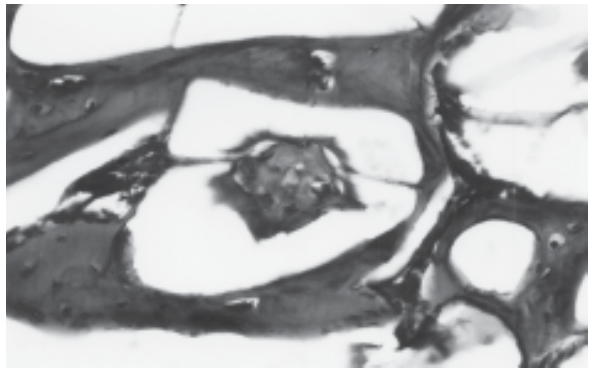
FIGURE 5 - PG 30 days. Spaces filled with particles surrounded by more mature bone tissue; indications of remodeling (A). In some of the spaces, the presence of bone tissue (B) can be observed (apparently formed inside them), as well as thin bone septa. Delicate fibrilar material inside other spaces, occasionally with reticular aspect. Bone trabeculae interspersed with bone marrow. Bone growth can be observed inside the granule.